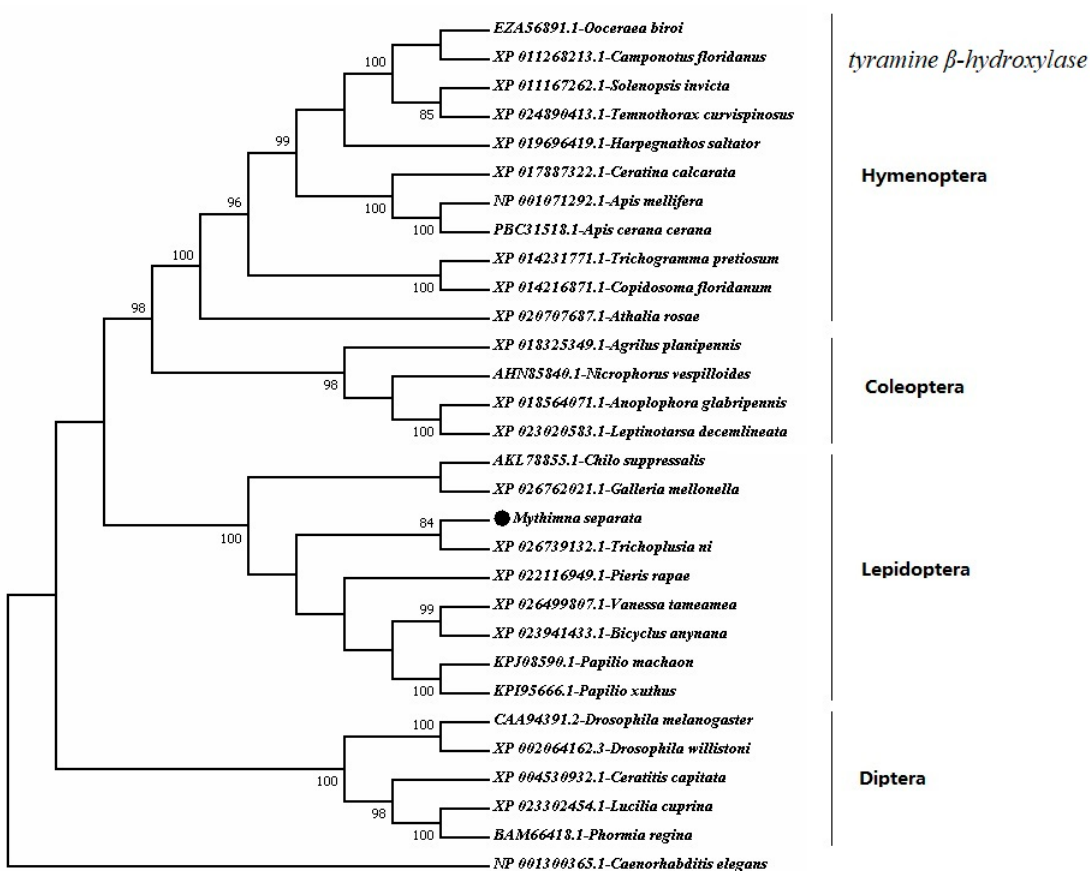
Figure 4. Phylogenetic tree of amino acid sequences of tyramine β -hydroxylases from different insecta orders (Lepidoptera, Hymenoptera, Coleoptera and Diptera) was constructed by MEGA 7.0. Caenorhabditis elegans tyramine β -hydroxylase was used as the out-group. The numbers at the nodes of the branches represent the level of bootstrap support for each branch.